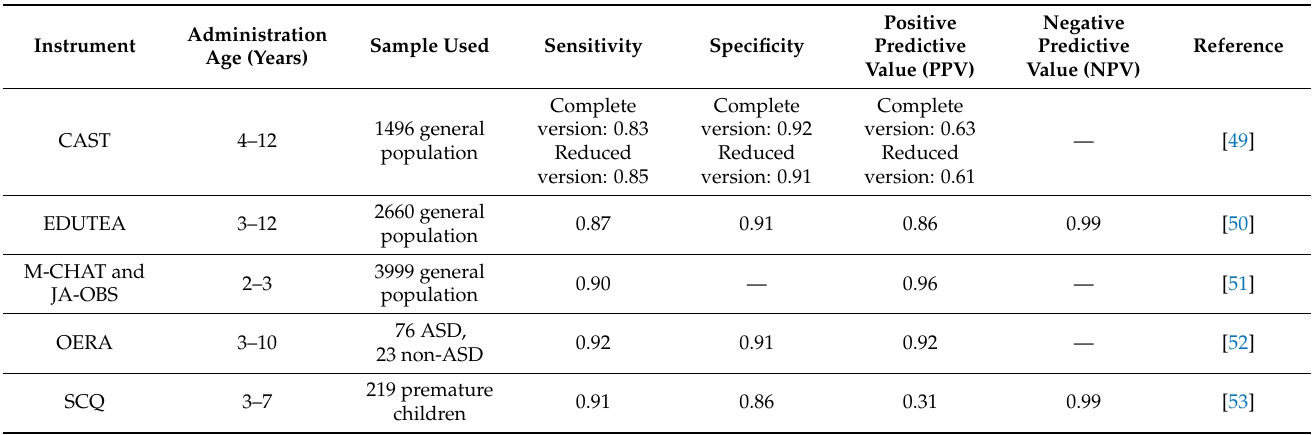
AQ-10: Short Autism Spectrum Quotient. ASD: Autism spectrum disorder. ASRS: Autism Spectrum Rating Scales. BASC-2: Behavior Assessment System for Children, Second Edition. PRS-P Scale: Parent Rating Scales—Preschool. CASD: Checklist for Autism Spectrum Disorder. CASD-SF: Checklist for Autism Spectrum Disorder, Short Form. CAST: Childhood Autism Spectrum Test. M-CHAT: Modified Checklist for Autism in Toddlers. JA-OBS: Joint Attention Observation of Toddlers. OPD: Other Pervasive Disorders. OREA: Structured Observation for Autism Screening (acronym in Portuguese). PPV: Positive predictive value. NPV: Negative predictive value. SCQ: Social Communication